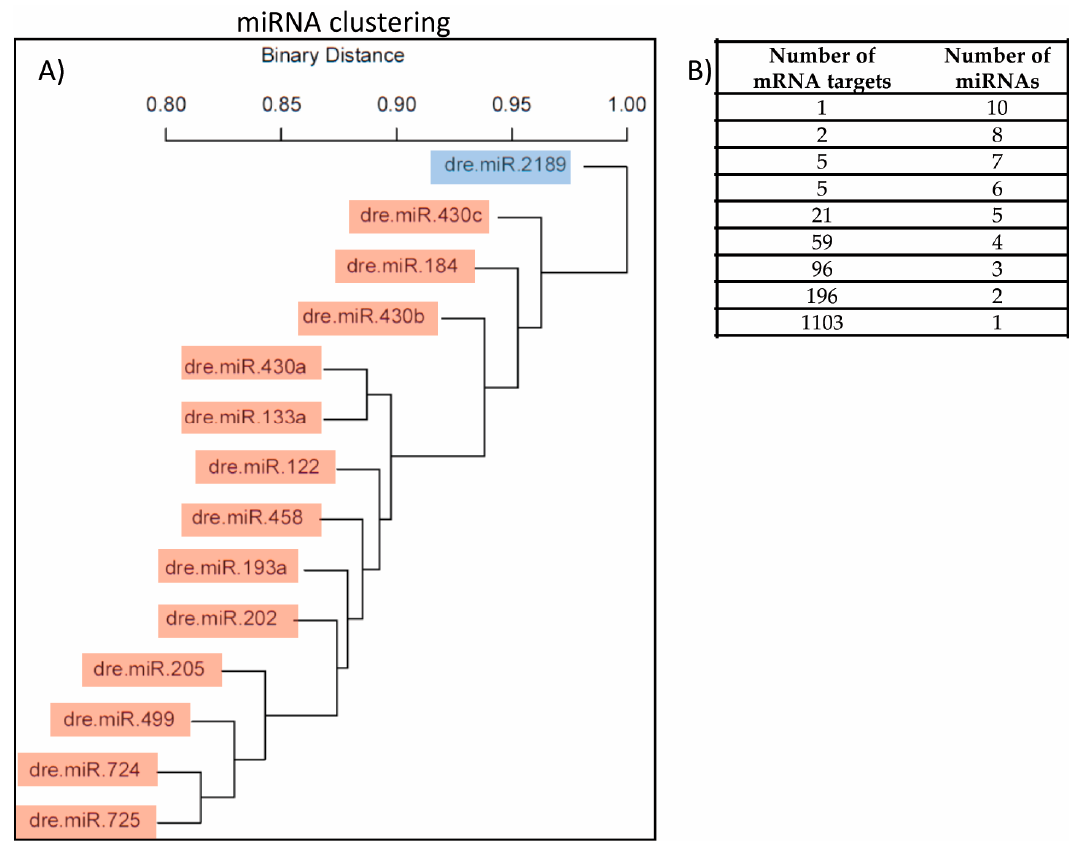
Figure 7. miRNA clustering & matrix. ( A ) miRNAs with similar target mRNAs cluster together. The miRNAs that are upregulated after BPA exposure are highlighted in RED, and dre-miR-2189, the only downregulated miRNA identified in this study, is highlighted in BLUE. For upregulated miRNAs, only predicted gene targets with a negative fold change (FC) present in the mRNA-Seq dataset ( q ≤ 0.1) were considered. For dre-miR-2189, only predicted gene targets with a positive FC were taken into account. Because dre-miR-2189 is the only miRNA targeting genes with positive FC, its score is equal to 1, showing that it is very different from all other miRNAs shown here. In contrast, dre-miR-725 and dre-miR-724 (left/bottom corner) have low scores and cluster together, meaning that they have several common target genes; in fact 72 mRNAs are predicted targets of these two